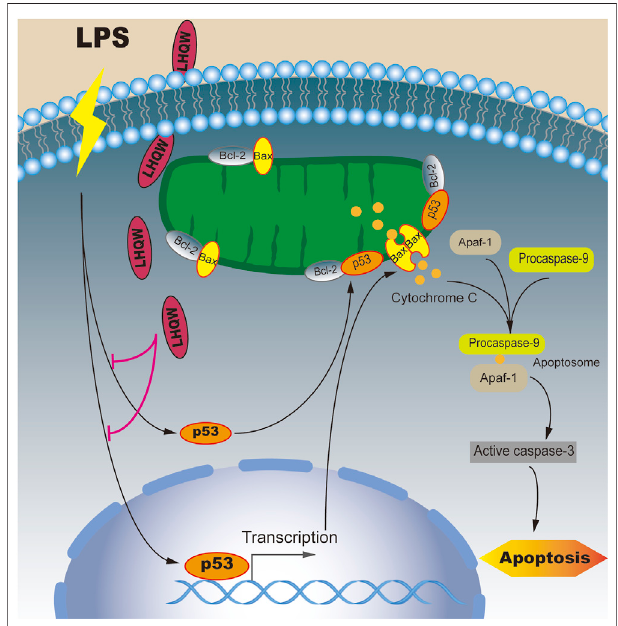
FIGURE 7 | Mechanisms underlying the inhibitory effect of LHQW on p53-mediated apoptosis in ALI induced by LPS. Under normal conditions, Bcl-2constantinteractedwithBaxandinhibitedBaxfromaccumulatingatthe mitochondrial outer membrane, thus suppressing cell apoptosis. Under LPS stimulation, p53 and its downstream target Bax were upregulated and translocated to mitochondrial outer membrane to form a homodimer. On the other hand, p53 was able to permeabilize the outer mitochondrial membrane by binding to Bcl-2. The accumulation of Bax on the outer mitochondrial membrane could promote the release of cytochrome C, which in turn led to the formation of apoptosomes (Apaf-1, cytochrome C and caspase-9). Once activated,theeffectorcaspasescouldinducecellapoptosis.LHQWtreatment could attenuate LPS-induced apoptosis by downregulating p53 expression.